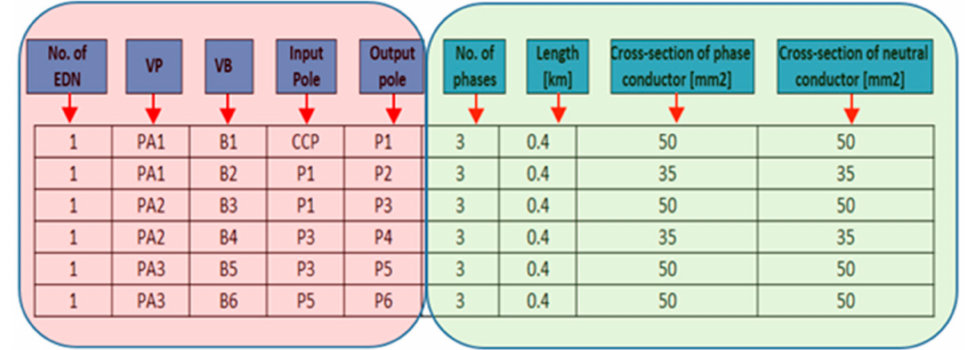
Figure 6. The data sequence extracted from the topology database.